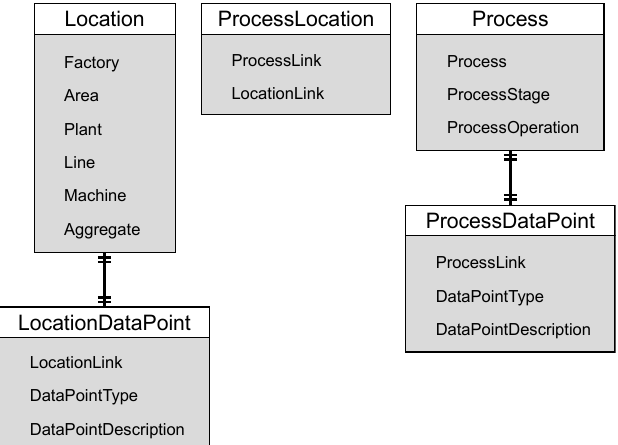
Figure 4. Entity-relationship diagrams (ERD) of tables for plant model, process model, and the link between them.